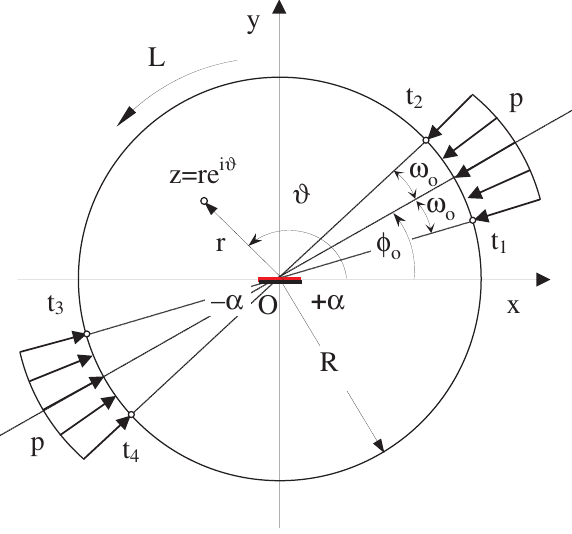
Figure 1 Configuration of the mathematical problem and definitions of